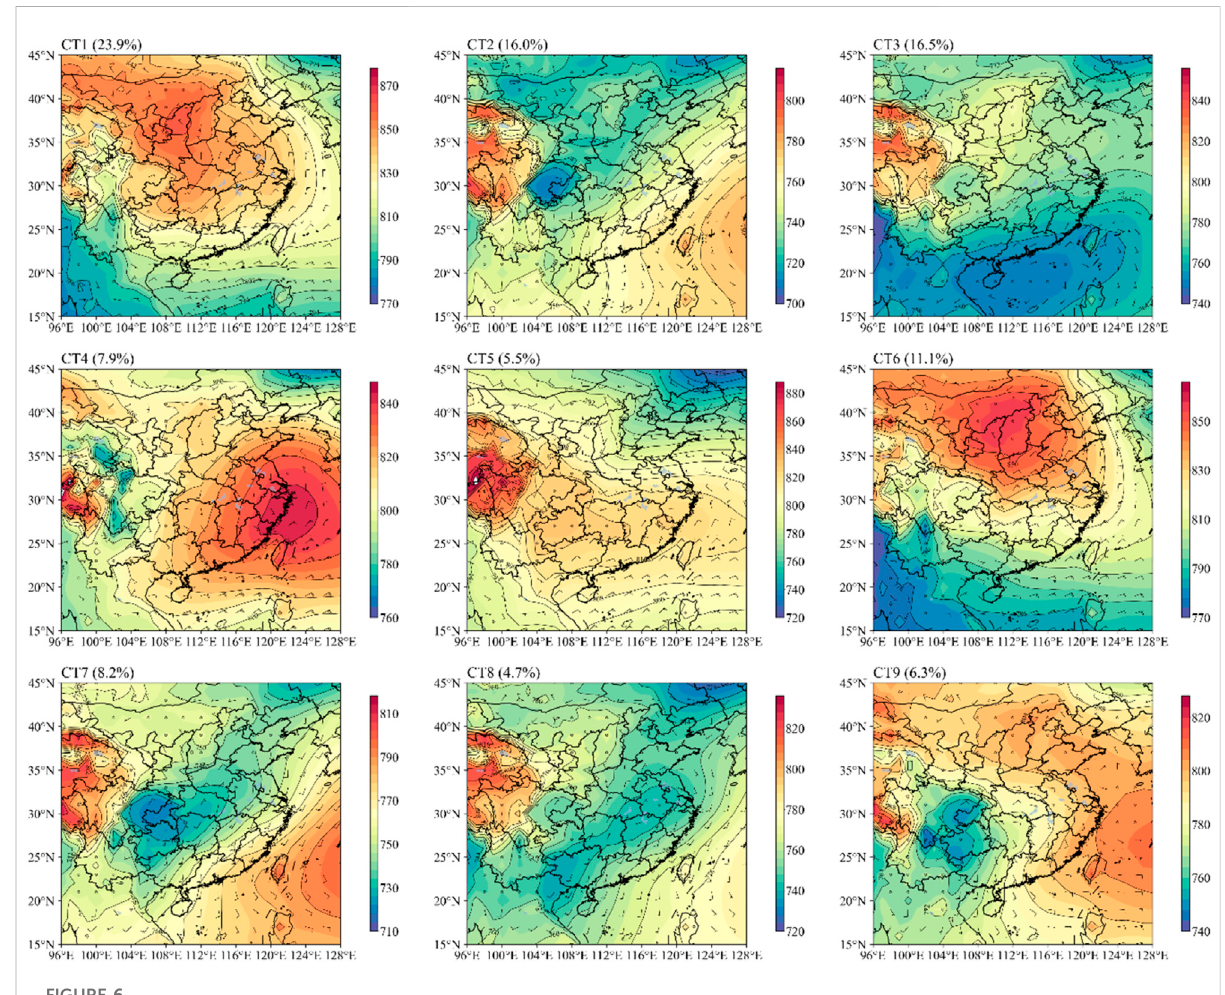
FIGURE 6 Contour plots showing the nine CTs at 925 hPa in the CZT region (unit: gpdm).